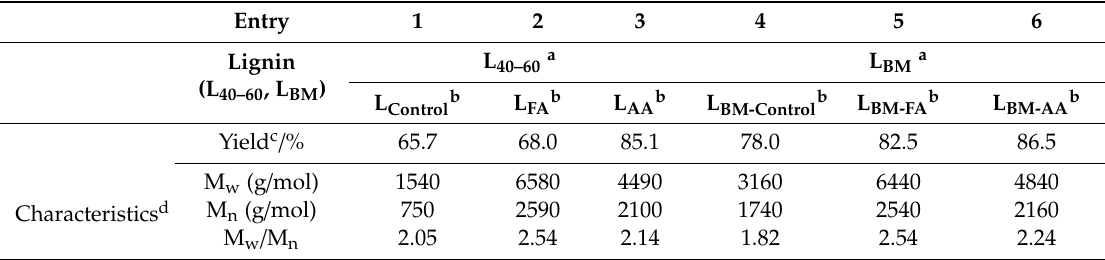
Table 1. The characteristics of lignin fractions obtained under di ff erent